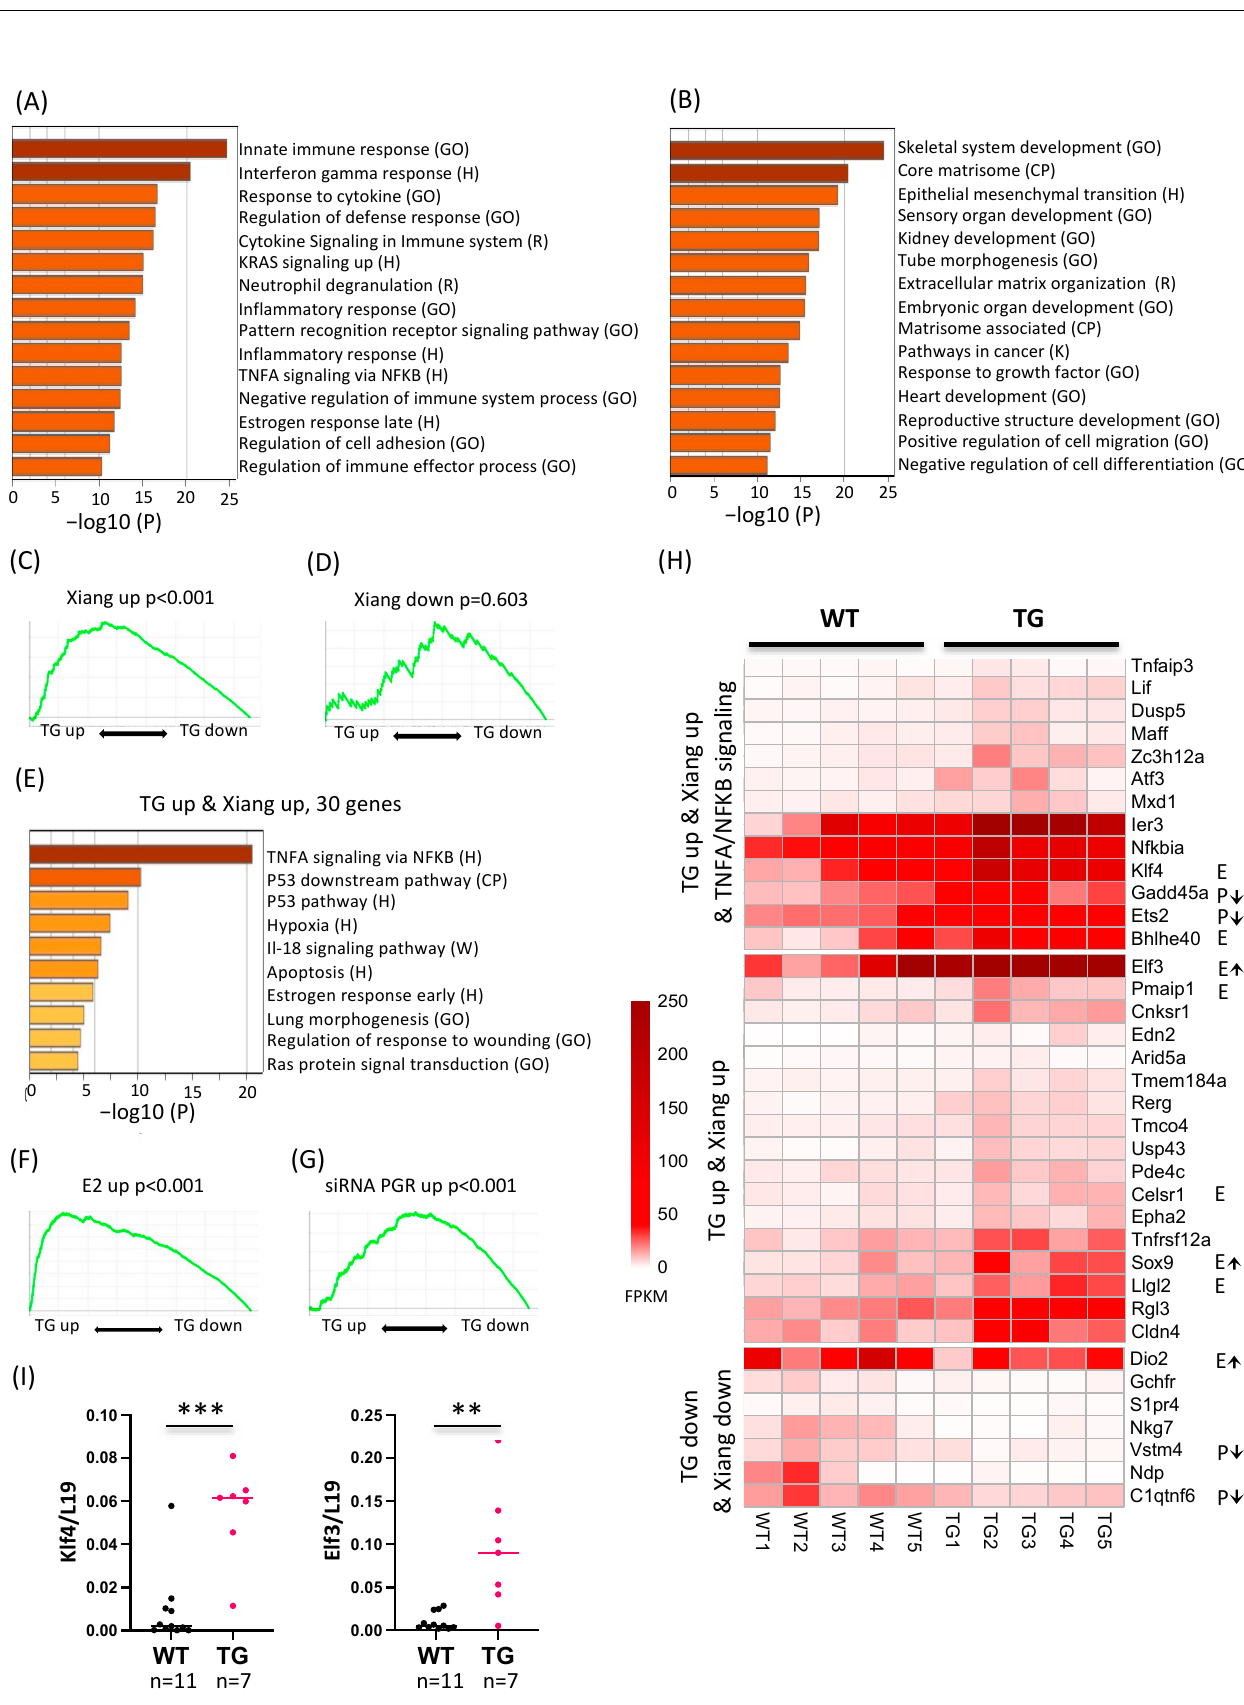
Figure 2. Transcriptomic uterine changes in HSD17B1TG females at the age of 4 months preceding adenomyosis development. Functional enrichment analysis of genes that were upregulated ( A )